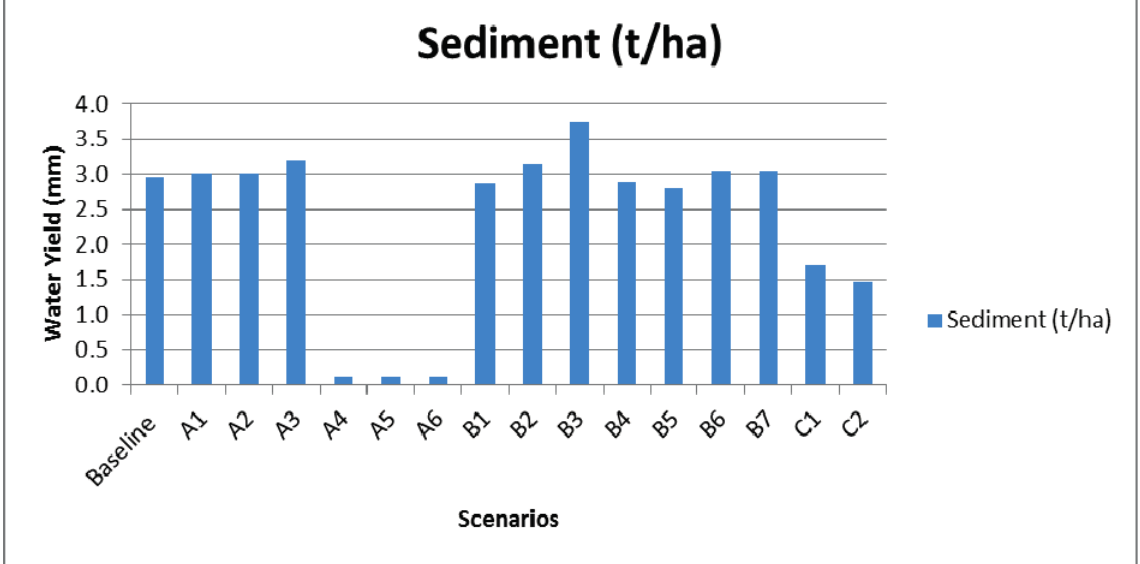
Figure 7. Annual average sediment load at the watershed scale under the 15 different